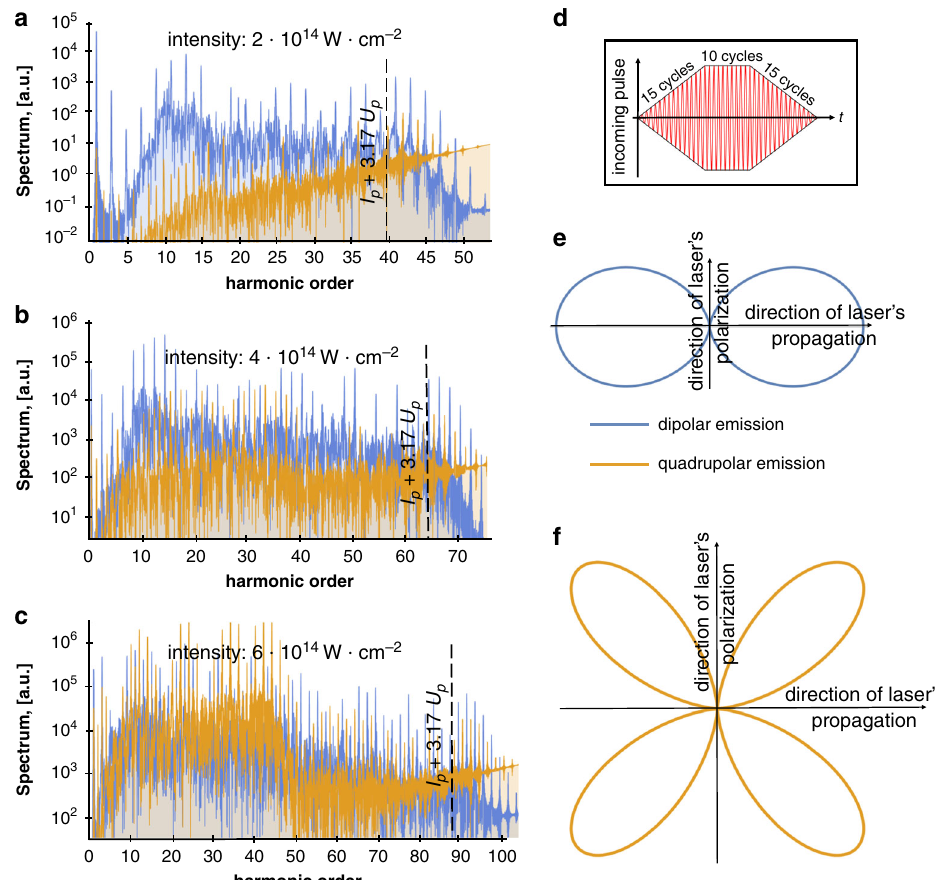
Fig. 5 Breakdown of the dipole approximation for the emitted high harmonic radiation. Numerical calculations of the spectrum use a 1D model of a helium atom. a – c Spectrum of dipolar (blue curve) and quadrupolar emission (yellow curve) for different intensities according to Eq. (7). The dashed vertical lines mark the conventional HHG cut-off energy I p + 3.17 U p , where I p is the helium ionization potential and U p the ponderomotive energy. The quadrupolar emission gives a signi fi cant contribution to the even harmonics and becomes larger for larger intensities. The wavelength of the driving fi eld is λ = 800 nm; the intensities of the driving fi eld are 2 × 10 14 W cm 2 , 4 × 10 14 W cm − 2 , and 6 × 10 14 W cm − 2 , respectively. d The form of the incident pulse- 0 trapezoidal pulse with 15 cycles rising on each side of trapeze and 10 cycles of the plateau of the trapeze. e , f Angular dependence of dipolar (blue) and quadrupolar (yellow) emission, respectively. The angular dependence in the insets is derived analytically (see Supplementary Note 9). The Ox and Oy axes are the directions of propagation and the direction of polarization of the driving fi eld,